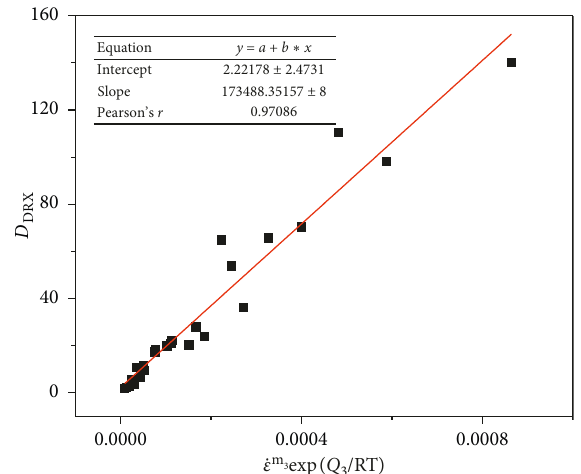
Figure 13: Relationships between D